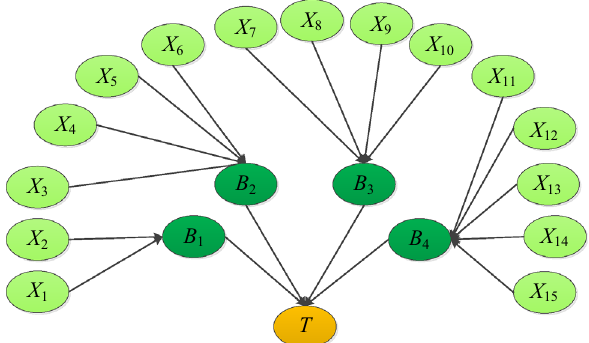
Figure 4. DAG of Bayesian network.